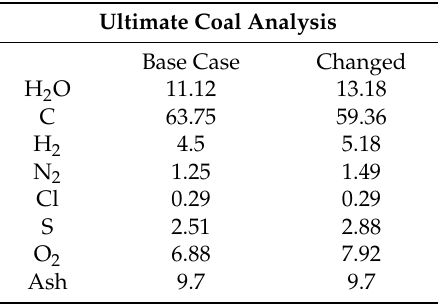
Table 3. Comparison of Coal Compositions for Disturbance Rejection Study.